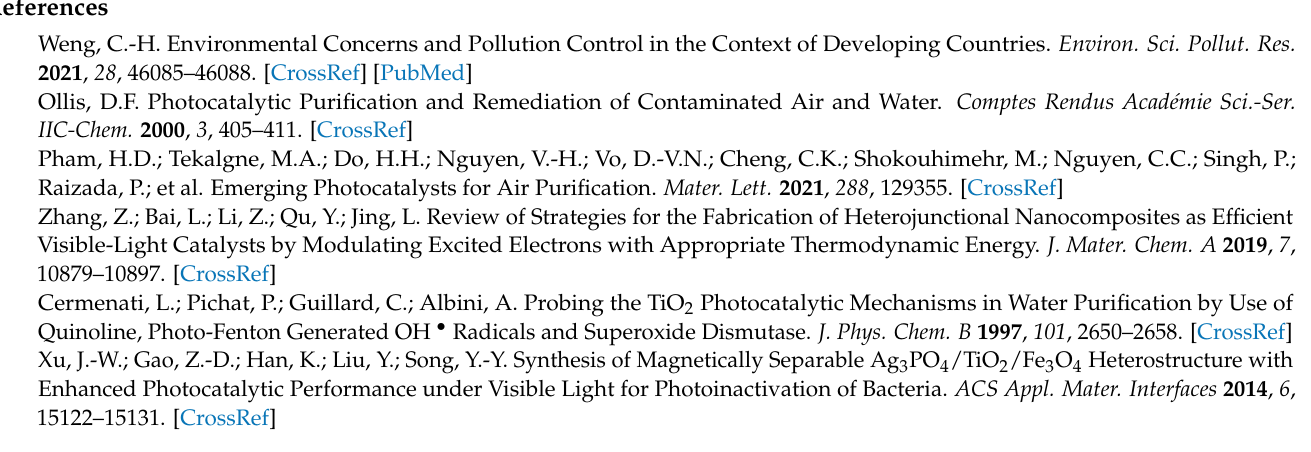
photocatalyst samples as indicated in the figure title; Figure S2. Evolution of the UV-visible absorption spectra of MB dye aqueous solution (10 ppm) under solar light irradiation performed with different photocatalyst samples as indicated in the figure. Figure S3. Plot of C/C 0 with reaction time performed with SiO 2 -AgP16 and TS82-AgP16 microsphere composite using (a) RhB and (b) MB dye Table S1. Photocatalytic reaction rate constant of the corresponding